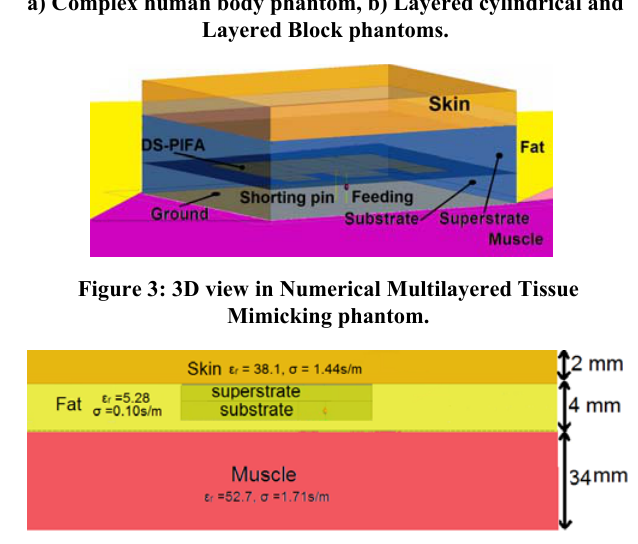
Figure 4. Side view in mimicking phantom.